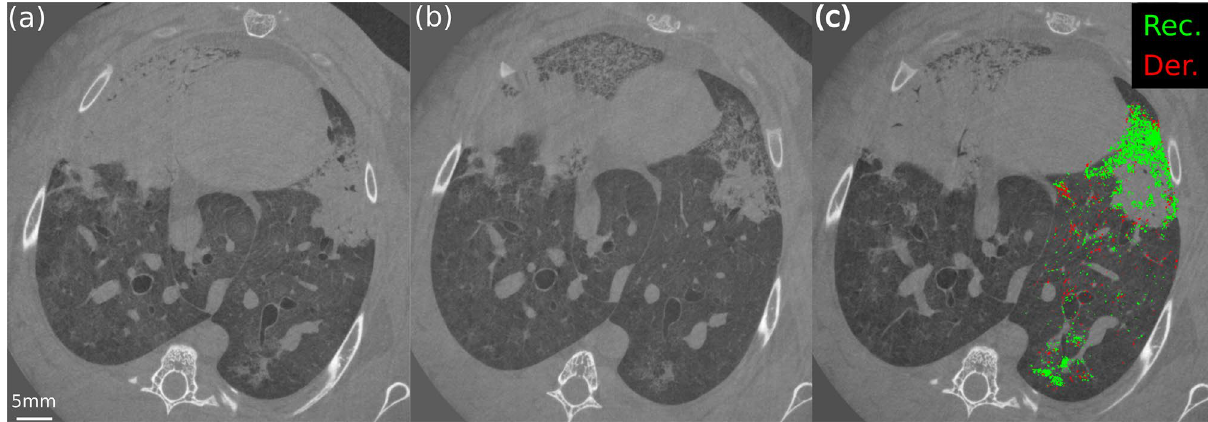
Figure 4. In vivo dynamic CT of Rabbit-1 at minimum pressure at the beginning of inspiration (5 cmH 2 O) ( a ) and at maximum pressure at the end of the inspiration (25 cmH 2 O ) ( b) . In ( c ) a 2D projection of the recruitment (Rec., green) and derecruitment (Der., red) as identified by the algorithm in the left lung, superimposed to one CT slice as a reference. ( c ) represents the time instant, during the respiratory cycle, where maximum recruitment was